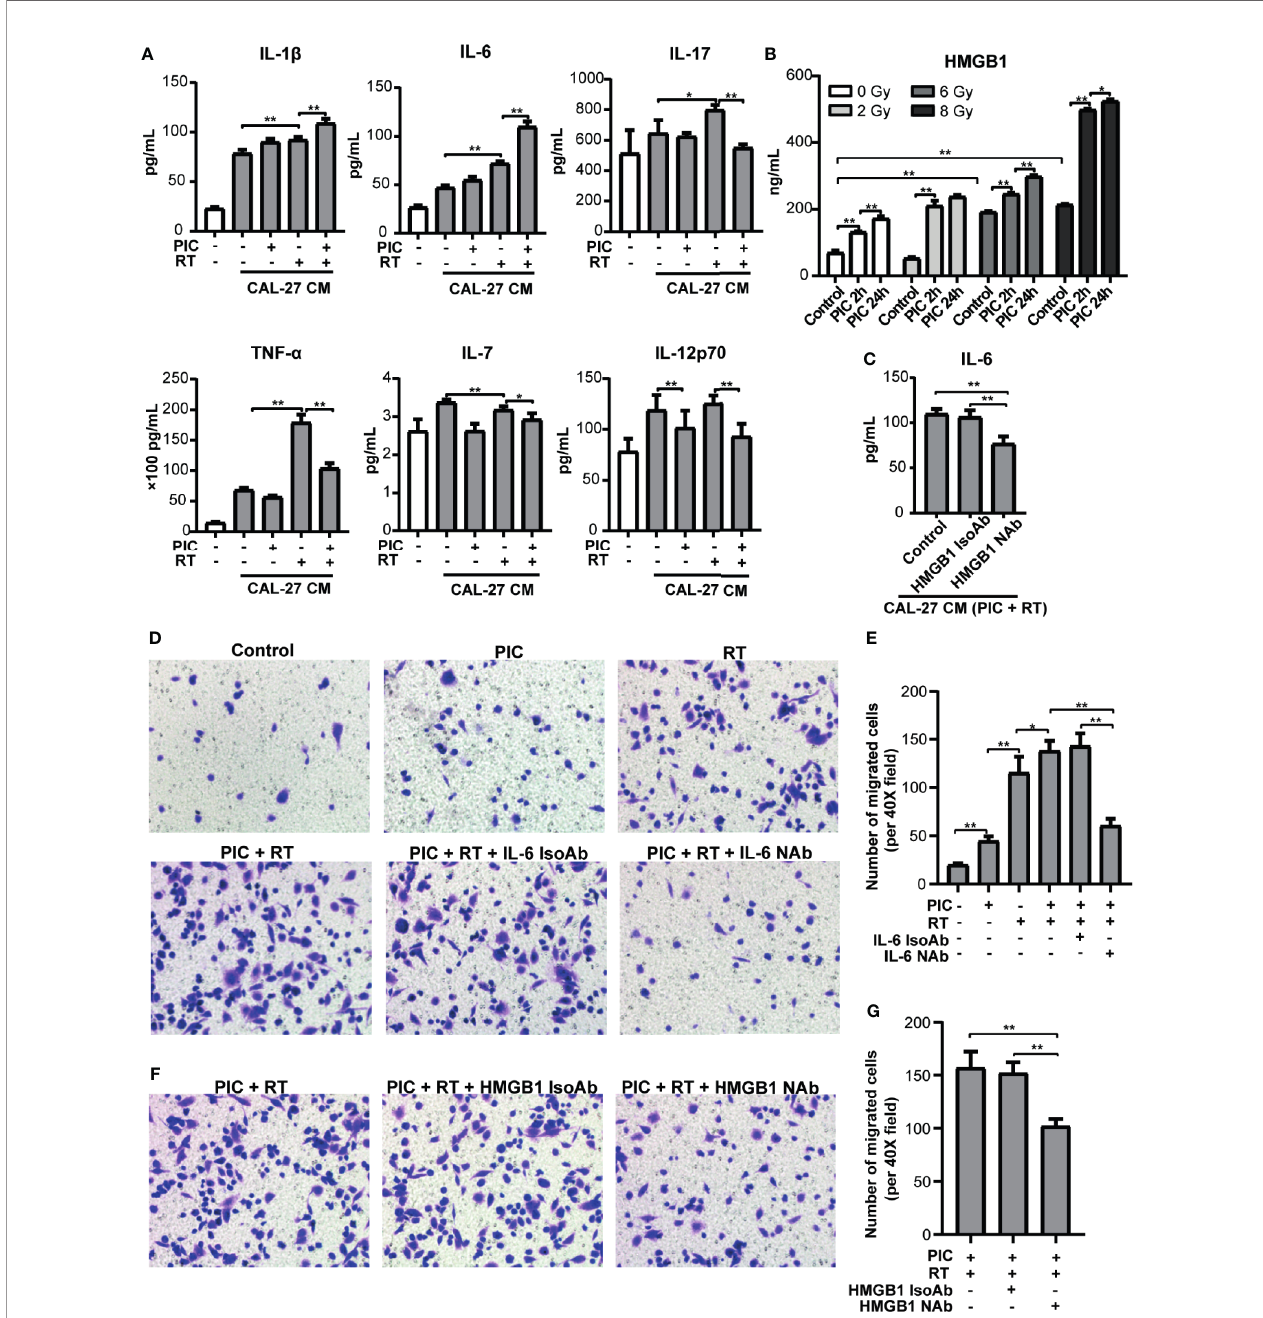
FIGURE 7 | Poly(I:C) and radiation-stimulated CAL-27 alters cytokine secretion of macrophages and promotes macrophage recruitment through IL-6 and HMGB1. CAL-27 cells were treated with poly(I:C) or PBS for 24 h followed by 8 Gy or 0 Gy radiation. THP-1-derived macrophages were treated with above CAL-27 CM (or no CM control) and continued to culture for 42 h before incubation for 24 h with fresh medium. (A) The concentrations of IL-1 b , IL-6, IL-17, TNF- a , IL-7, and IL-12p70 in the supernatants were detected by cytokine assay. ANOVA was used (mean ± SD, n = 5). (B) Bar plot shows HMGB1 concentrations in CAL-27 CM detected by ELISA. Mann-Whitney U-test was used (mean ± SD, n = 3). (C) Bar plot shows the concentration of IL-6 in the supernatants of THP-1-derived macrophages treated with CAL-27 CM (poly (I:C) 24 h combined 8 Gy radiation) or pretreated with HMGB1 neutralizing antibody or isotype antibody. (D, E) Representative images (×200) and quanti fi cations of the migrated THP-1-derived macrophages treated with CAL-27 CM and IL-6 neutrolizing antibody (or isotype). (F, G) Representative images (×200) and quanti fi cations of the migrated THP-1-derived macrophages treated with CAL-27 CM and HMGB1 neutrolizing antibody (or isotype). ANOVA was used (mean ± SD, n = 5). * indicates P < 0.05 and ** indicates P < 0.01. PIC, poly (I:C); CM, condition medium; RT, radiation. NAb, neutralizing antibody; IsoAb, isotype